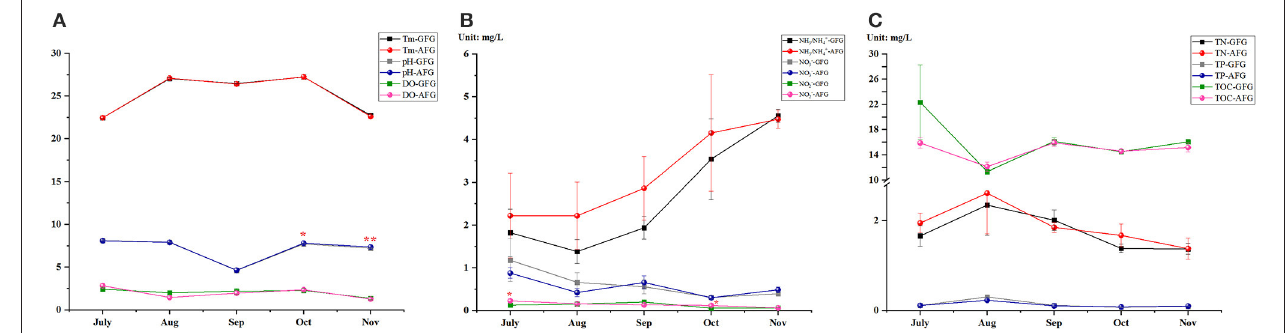
FIGURE 2 | Water quality parameters of two experimental groups. The different chemical elements in water body of grass feed group (GFG) and artificial feed group (AFG), including (A) temperature (Tm), dissolved oxygen (DO), pH; (B) various forms of nitrogen (NH 3 /NH + 4 , NO − 3 , NO − 2 ) and (C) the total amount of various chemical elements (total nitrogen—TN, total phosphorus—TP, and total organic carbon—TOC) were tested in every month from July to November. Vertical bars represent the mean S.E. Meanwhile, the red color star bars indicate the significance between the two experimental groups, *means significant ( P < 0.05), **means greatly ± significant ( P < 0.01).